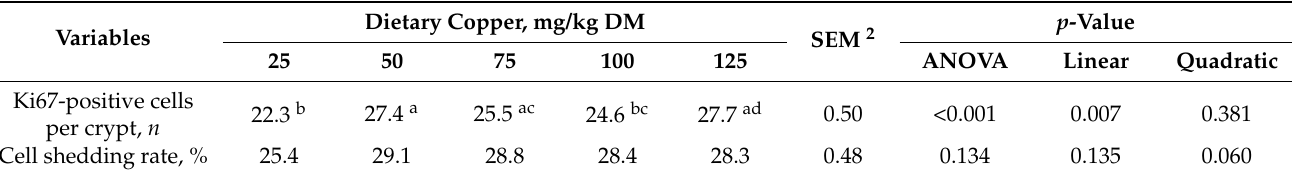
Table 4. Effects of dietary copper supplementation on intestinal epithelium renewal of weaned pigs 1 . Variables